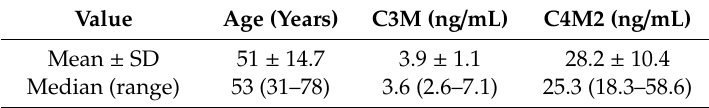
Table A3. Serum levels of collagen degradation markers in healthy